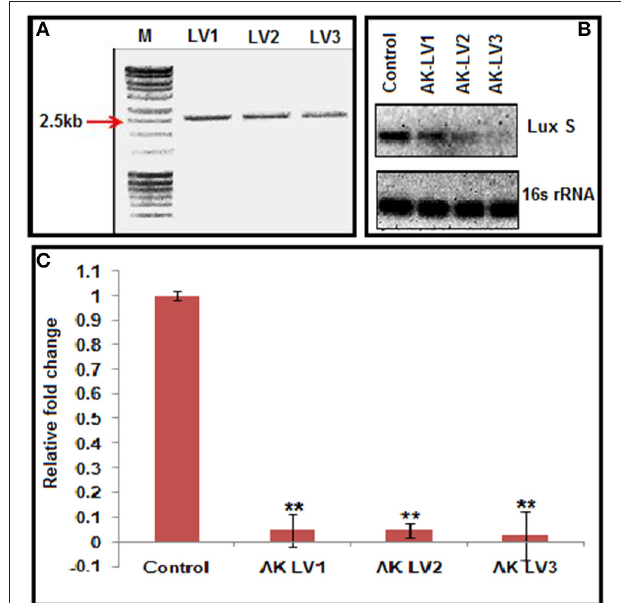
FIGURE 2 | (A) Inverse PCR product of 2,500 bp showing successful integration of target specific sgRNA. (B) Semi-quantitative data of LuxS gene (Control, AK-LVI, AK-LV2, and AK-LV3) and 16s rRNA gene as positive control. (C) Expression profile of luxS gene evaluated through qRT-PCR after CRISPRi mediated inhibition, ( ** P < 0.005, t -test, 2